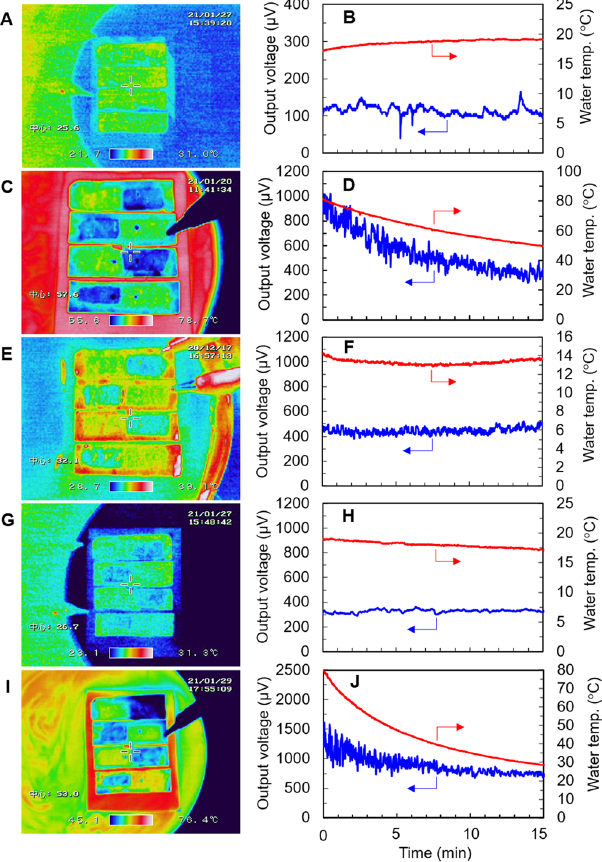
Figure 3. Temperature distribution and performance of the water-floating SWCNT film TEGs for various environmental conditions. Thermographic images of the TEG corresponding to ( A ) no sunlight or wind exposure at an initial temperature of approximately 20 °C, ( C ) no sunlight or wind exposure at an initial temperature of approximately 80 °C, ( E ) simulated sunlight but no wind, ( G ) wind but no simulated sunlight, and ( I ) both simulated sunlight and wind exposure at an initial temperature of approximately 80 °C. ( B , D , F , H , J ) Evolution of the output voltage (blue data) and water temperature (red data) corresponding to the conditions in ( A , C , E , G , I ),